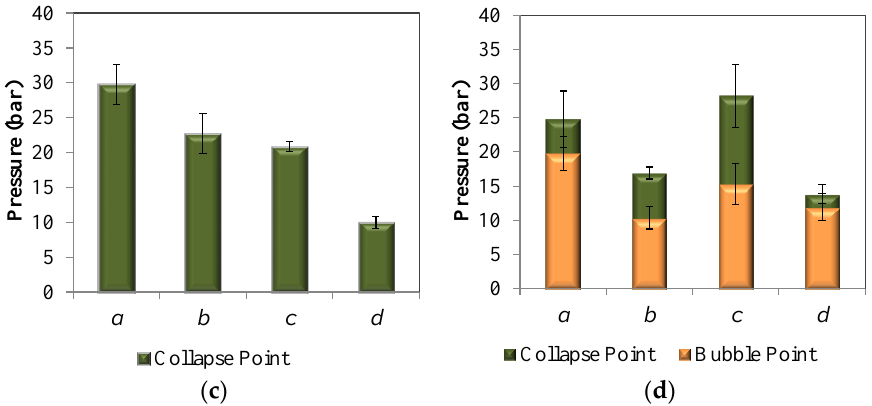
Figure 4. Failure pressures for the four tested hollow fibers: ( a ) pressurized from the bore side, dry; ( b ) pressurized from the bore side, wetted with [C 6 mim][Tf 2 N]; ( c ) pressurized from the shell side, dry; ( d ) pressurized from the shell side, wetted with [C 6 mim][Tf 2 N]. Bubble and rupture points for hollow fibers that were wetted with [C 6 mim][Tf 2 N] and pressurized